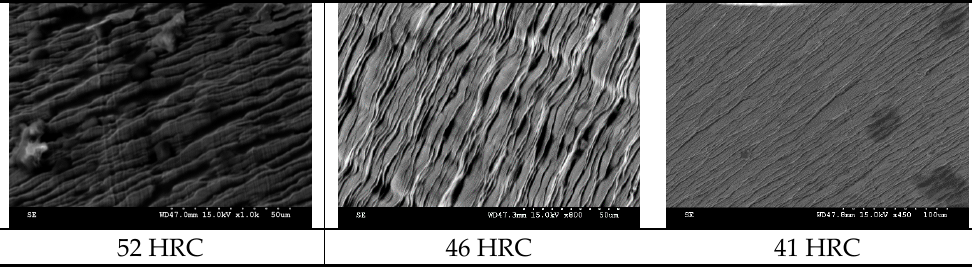
Figure 22. Microstructure of chips obtained at tested hardnesses.